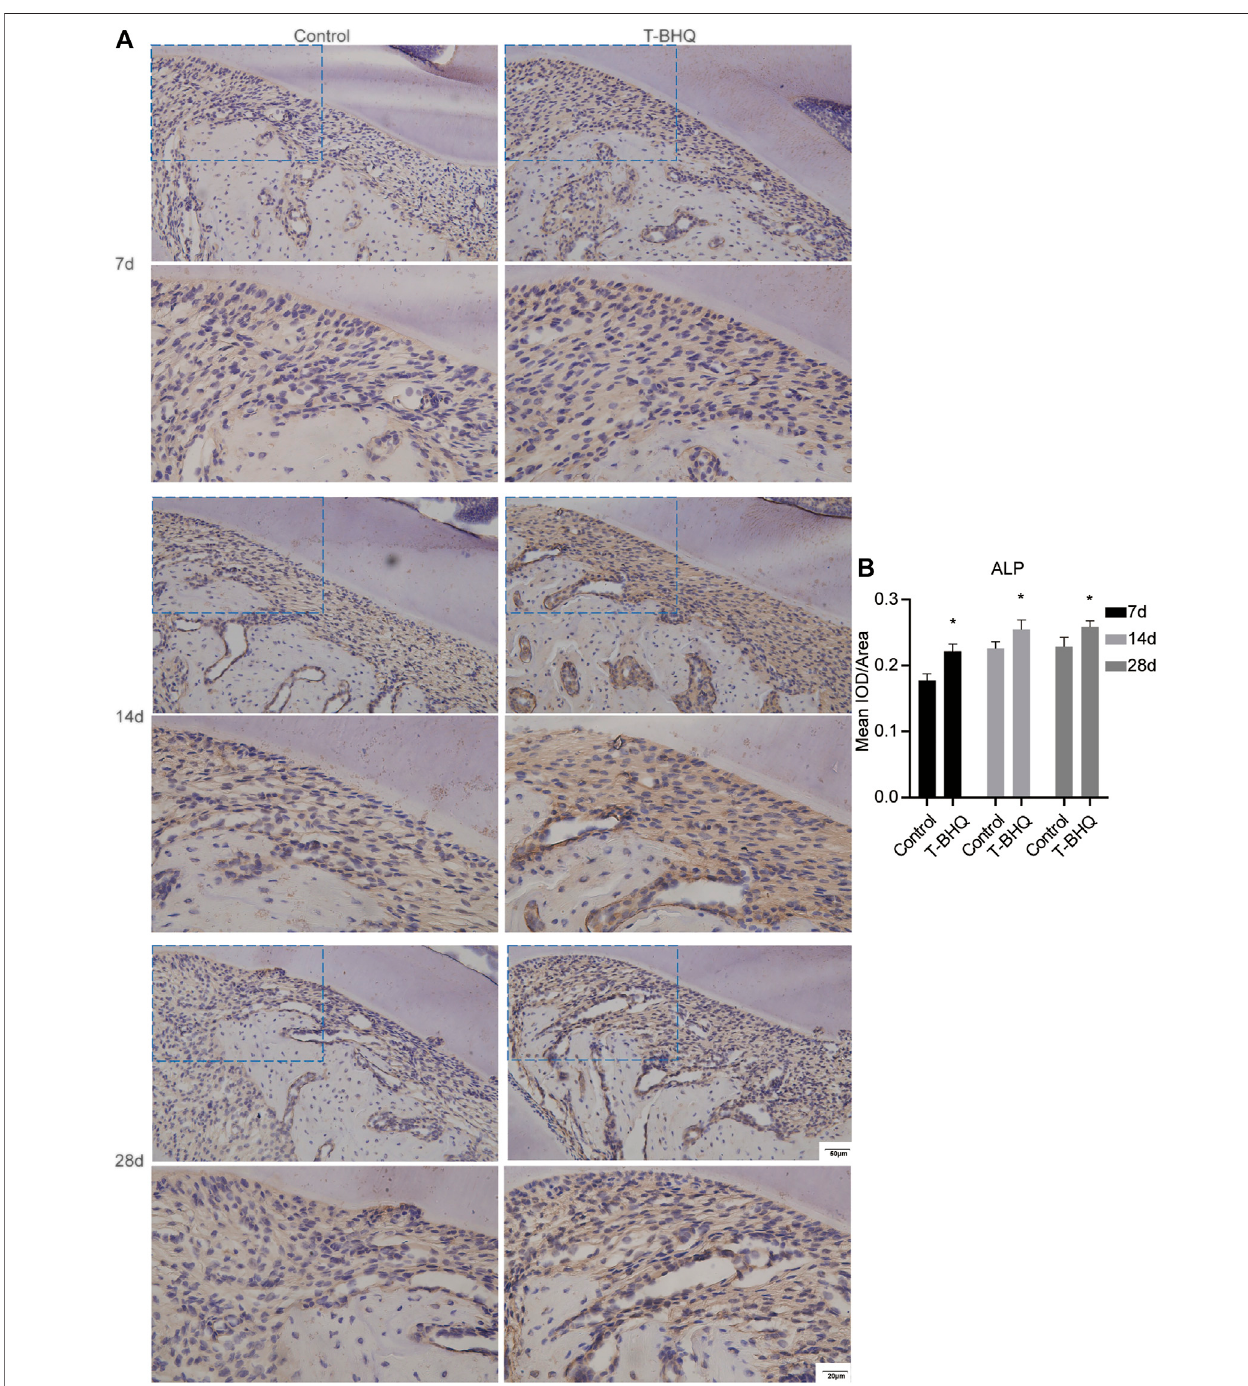
FIGURE7| TheincreasedexpressionofALPinthePDLatthetensionsideinorthodonticratswitht-BHQtreatment. (A) TheexpressionofALPwasenhancedwith t-BHQ treatment in the PDL at the tension side in orthodontic rats through IHC staining. The scale bars, 20 and 50 µm. (B) The mean IOD/Area of ALP was quanti fi ed through Image-Pro Plus 6.0 software. N (cid:1) 3 specimens in each group.